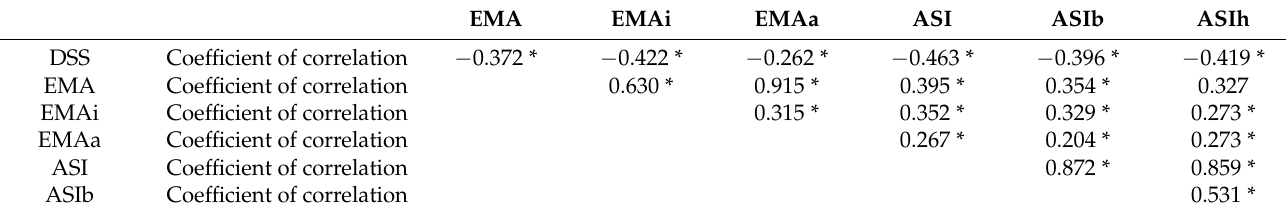
Table 5. Spearman’s Rho coefficient of